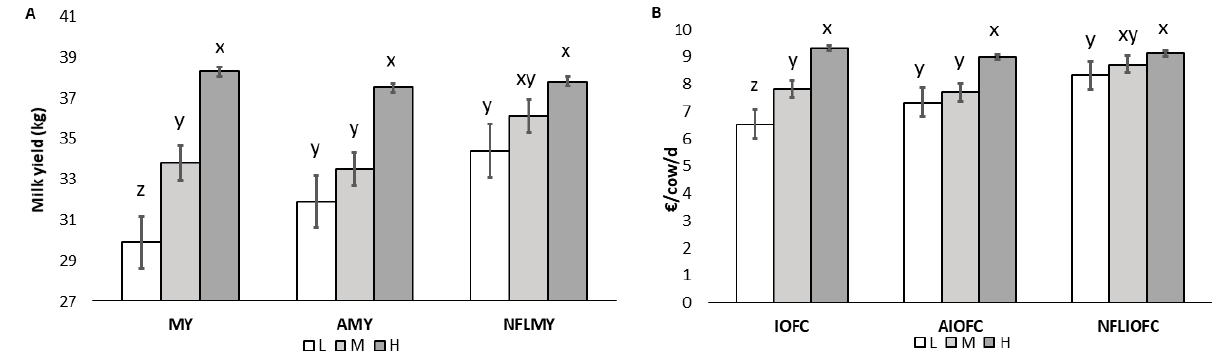
Figure 2. ( A ) Average milk yield (MY), achievable milk yield (AMY) and no feeding-limited milk yield (NFLMY) in low (L), medium (M) and high (H) production classes; ( B ) income over feed cost (IOFC), achievable income over feed cost (AIOFC) and no feeding-limited income over feed cost (NFLIOFC) in low (L), medium (M) and high (H) production classes. x, y, z Different letters between production classes stand for a significant difference ( p < 0.05). Error bars represent the standard error for each production class.